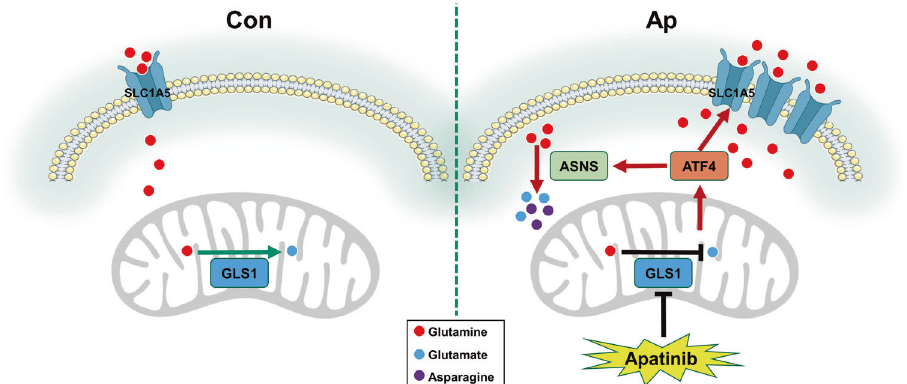
Fig. 7 Mechanistic diagram of apatinib in NSCLC cells. Apatinib inhibits GLS1, which leads to the activation of ATF4. ATF4 upregulates SLC1A5 and ASNS by binding to their promoters. The increase in SLC1A5 contributes to the overabsorption of glutamine. The upregulation of ASNS promotes the reaction of glutamine and aspartate to generate glutamate and asparagine. Thus, apatinib enhances the uptake and catabolism of glutamine in NSCLC